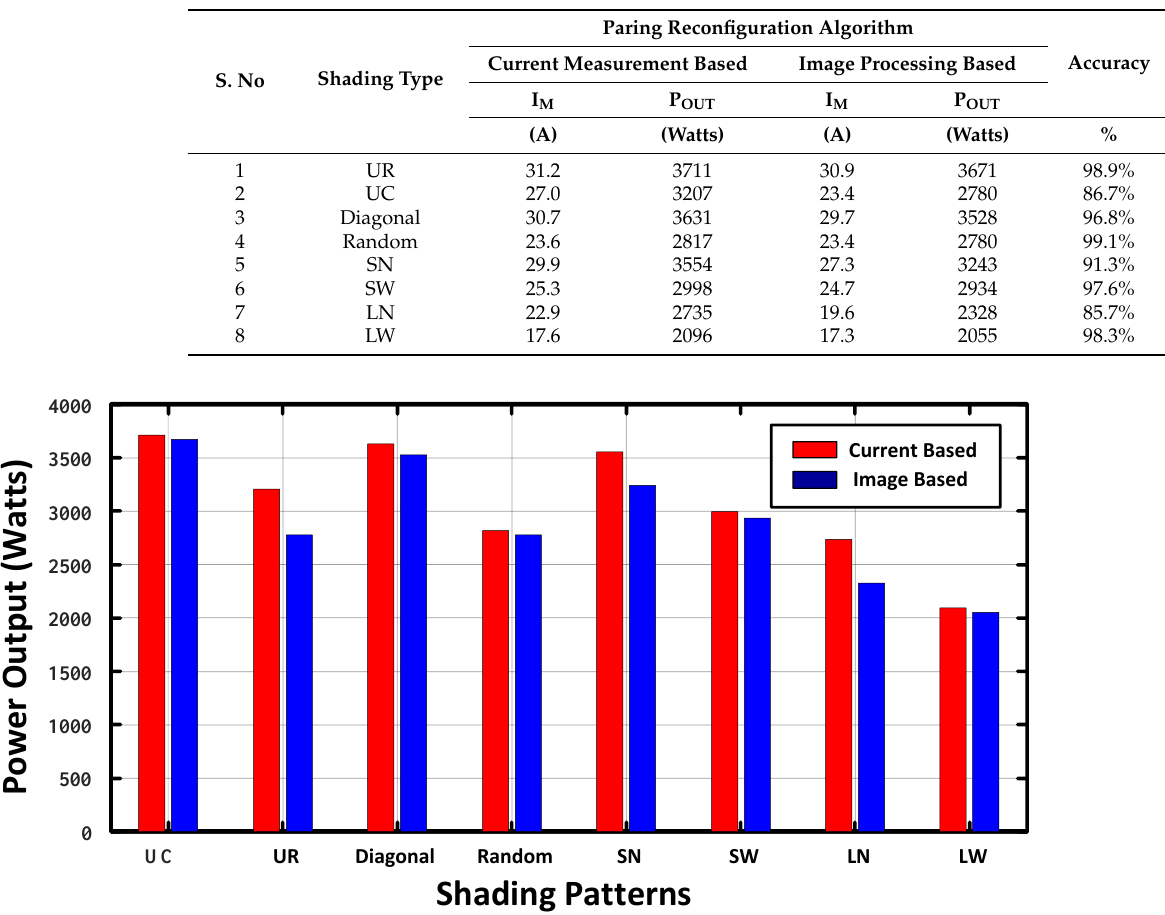
Figure 18. Comparison chart of output power.